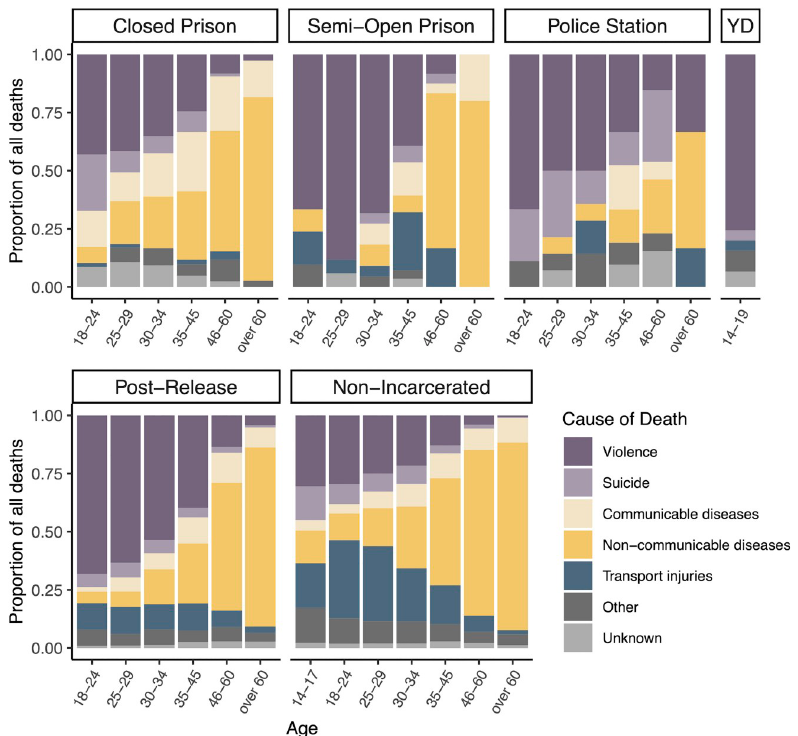
Fig 2. Proportions of cause-specific deaths by age, carceral facility, and incarceration history. Stacked bar plots indicating the proportions of deaths of men and boys resulting from each cause category, stratified by age group, carceral facility type, and incarceration status. Post-release refers to release from prison. Non-incarcerated refers to male Mato Grosso do Sul residents who did not have a record in the state’s incarceration database between 2005 and 2018. YD, youth